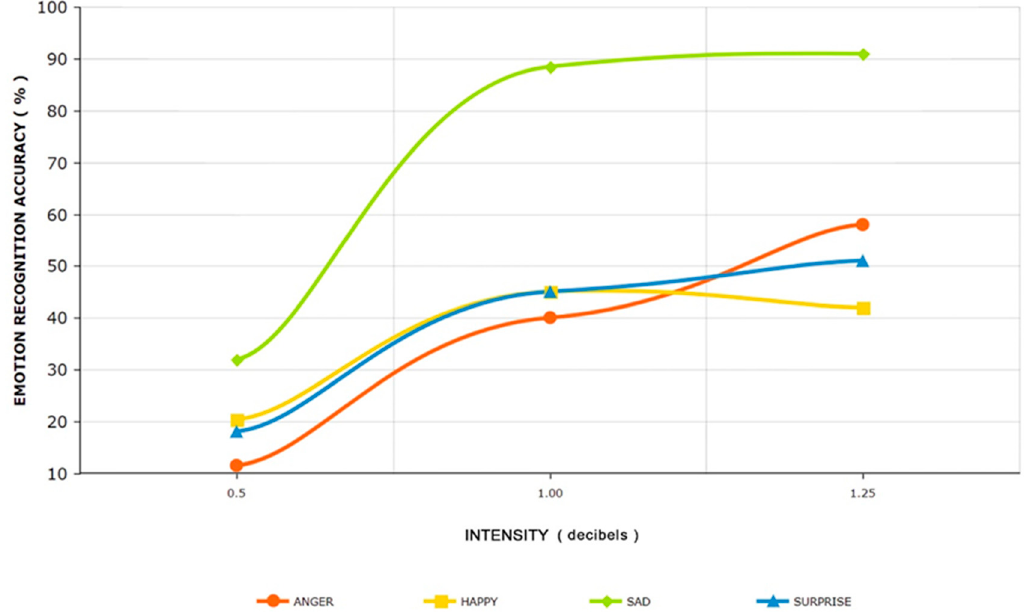
Figure 4. The overall mean for emotion perception by Asian ethnics based on speech intensity.